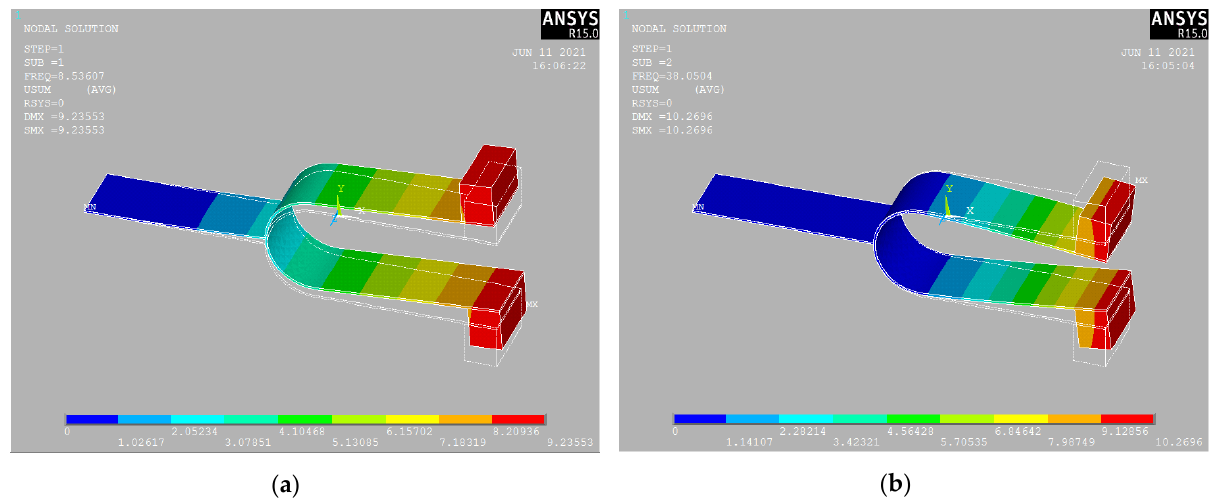
Figure 2. ( a ) The in-phase vibration mode and ( b ) the anti-phase vibration mode.